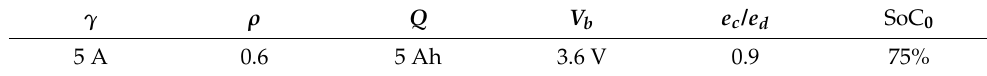
Table 5. Battery parameters for each 3U nanosatellite in the constellation. γ